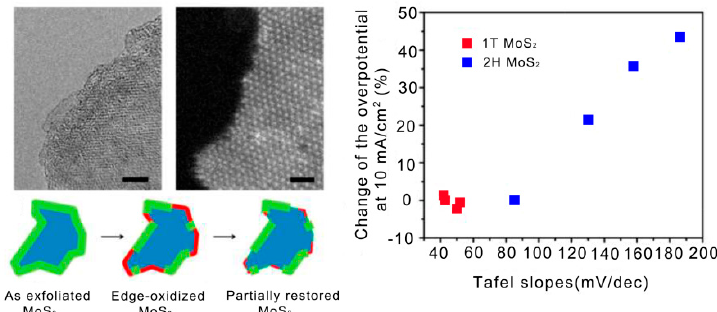
Figure 3. Edge-oxidized MoS 2 nanosheet by TEM and HAADF STEMR and the activity of 1H-MoS 2 and 2H-MoS 2 affected by the oxidation. Reproduced from [59], with the permission of the American Chemical Society.